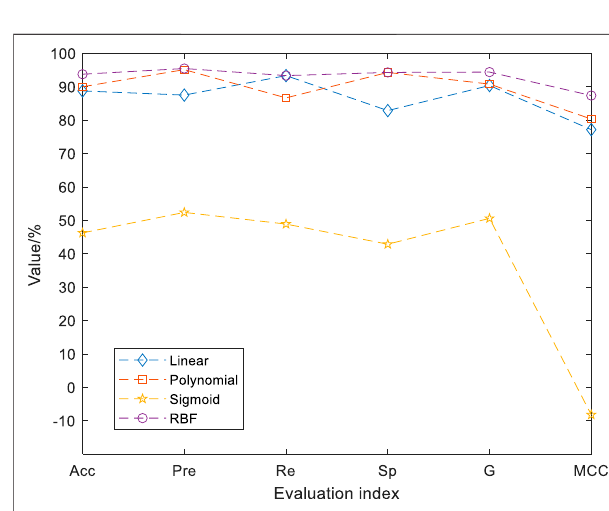
FIGURE 3 | Importance score of different physical signs. From top to bottom, the importance score of 12 physical signs are decreased continuously. The DBP has the highest importance, with a value of 0.18. The TWA is the least important, with a value of 0.0006.